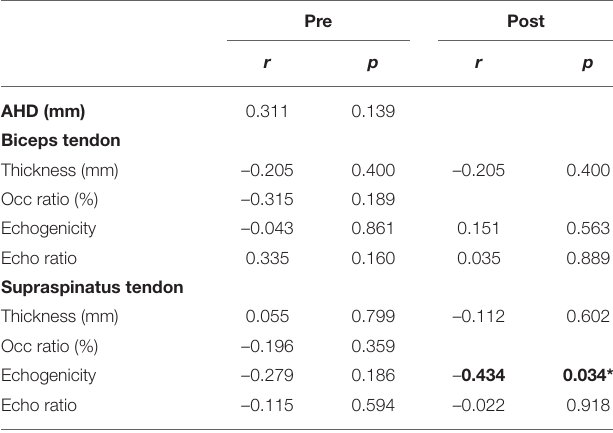
TABLE 3 | Association between acromio-humeral distance (AHD), tendon characteristics, and shoulder